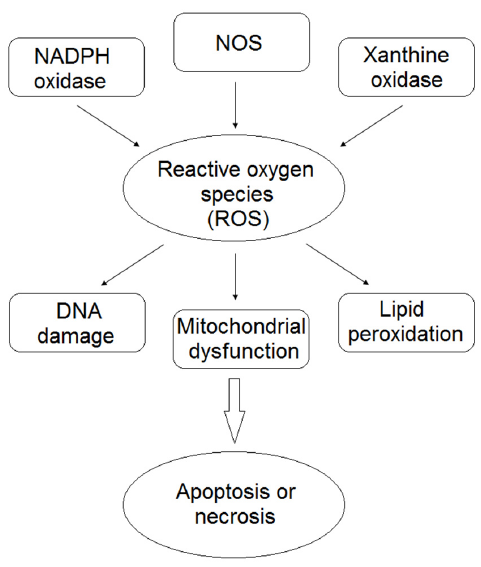
Figure 1. Generation of reactive oxygen species (ROS) and their cellular effects.